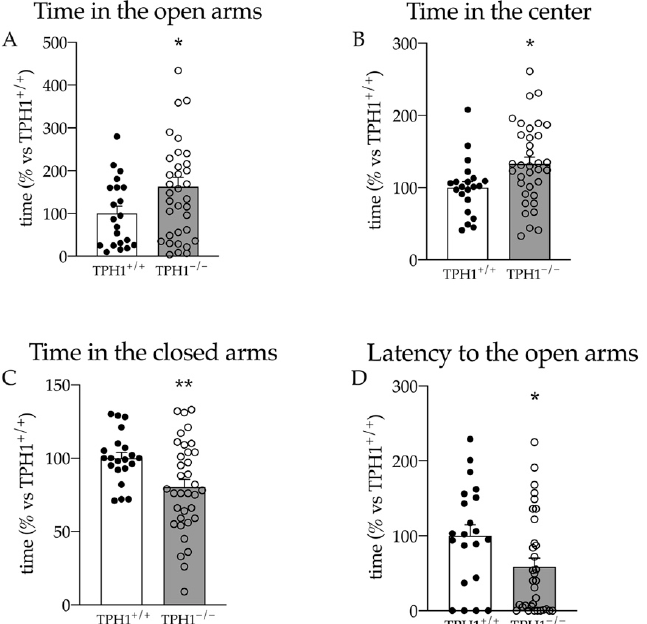
Figure 3. Elevated plus maze test results. Time spent in the open arms ( A ), in the center ( B ), in the closed arms ( C ) and latency to the first entrance in the open arms ( D ). Data are presented as mean ± standard error of the mean (SEM) of at least 21 independent determinations. * p < 0.05; ** p < 0.01 vs. TPH1 +/+ ; Student’s t -test.